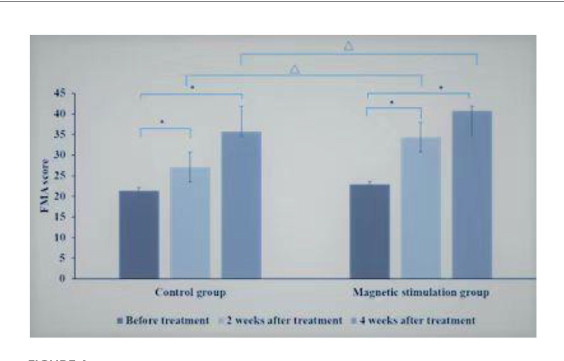
FIGURE 4 Comparison of FMA scores between control group and magnetic stimulation group. * p < 0.001; ∆ p < 0.001.